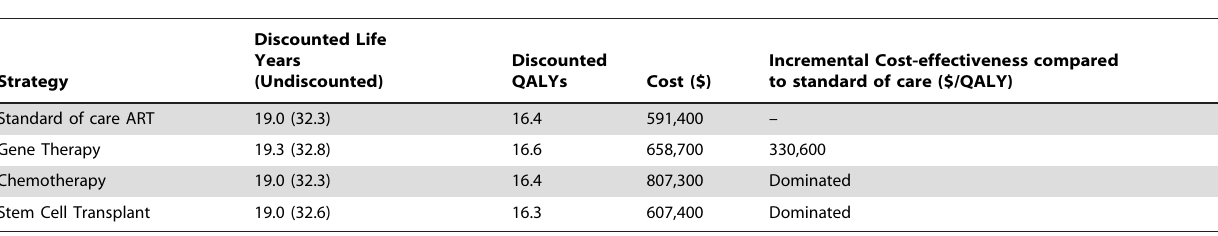
Table 2. Base case results of an analysis of hypothetical HIV cure strategies*.